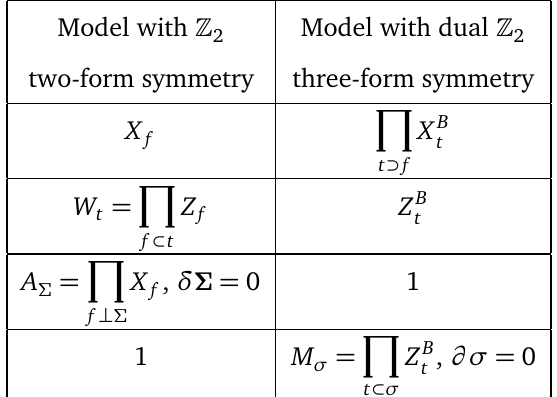
Table 2: In the process of gauging the one-form symmetry in 4d, the generators of lo- cal, one-form symmetric operators are mapped according to the duality above. The symmetry operators A Σ , the product of X codimension-2 surface Σ , are mapped to the identity in the dual theory. The system on the right-hand side has a (cid:90) ators M σ , where σ is a closed 3d surface on the direct lattice.